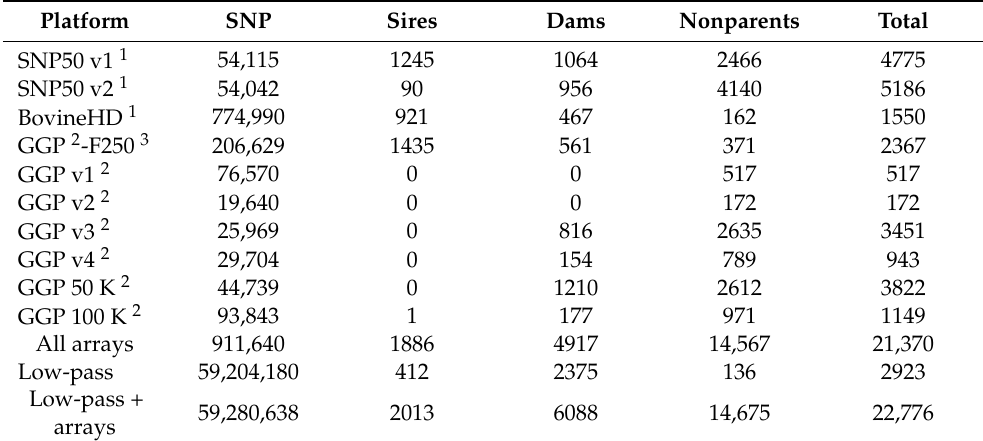
Table 1. Genotypes available from the Germplasm Evaluation project